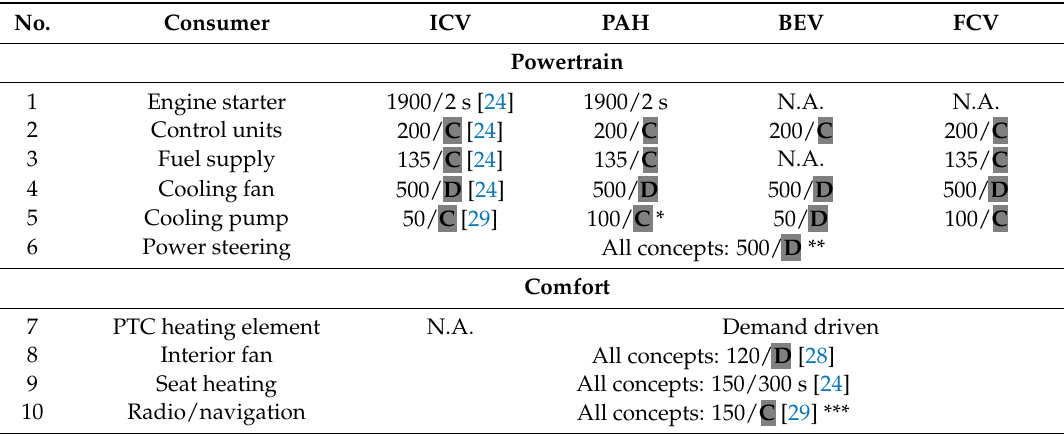
Table 3. Electric power requirement of auxiliary consumers. Values in [(cid:1849) (cid:3032) ] ; Sources: [24–29] C : continuous operation; D : demand-driven operation; f/r: front/rear; N.A.: not applicable; PTC: Positive temperature coefficient.